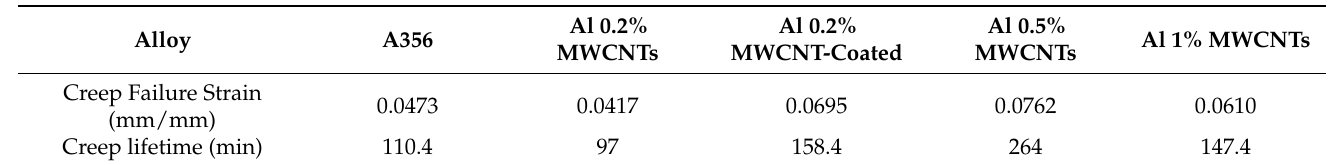
Table 5. Creep strain failure and lifetime of A356 aluminum alloy, nanocomposites with 0.2%, 0.2%-coated, 0.5%, and 1% MWCNTs.